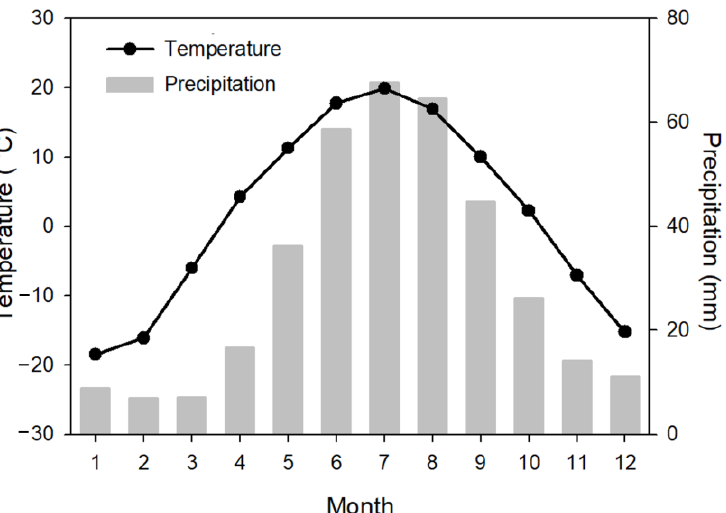
Figure 2. Monthly mean air temperature and monthly precipitation from the Minusinsk weather station from 1966 to 2018.